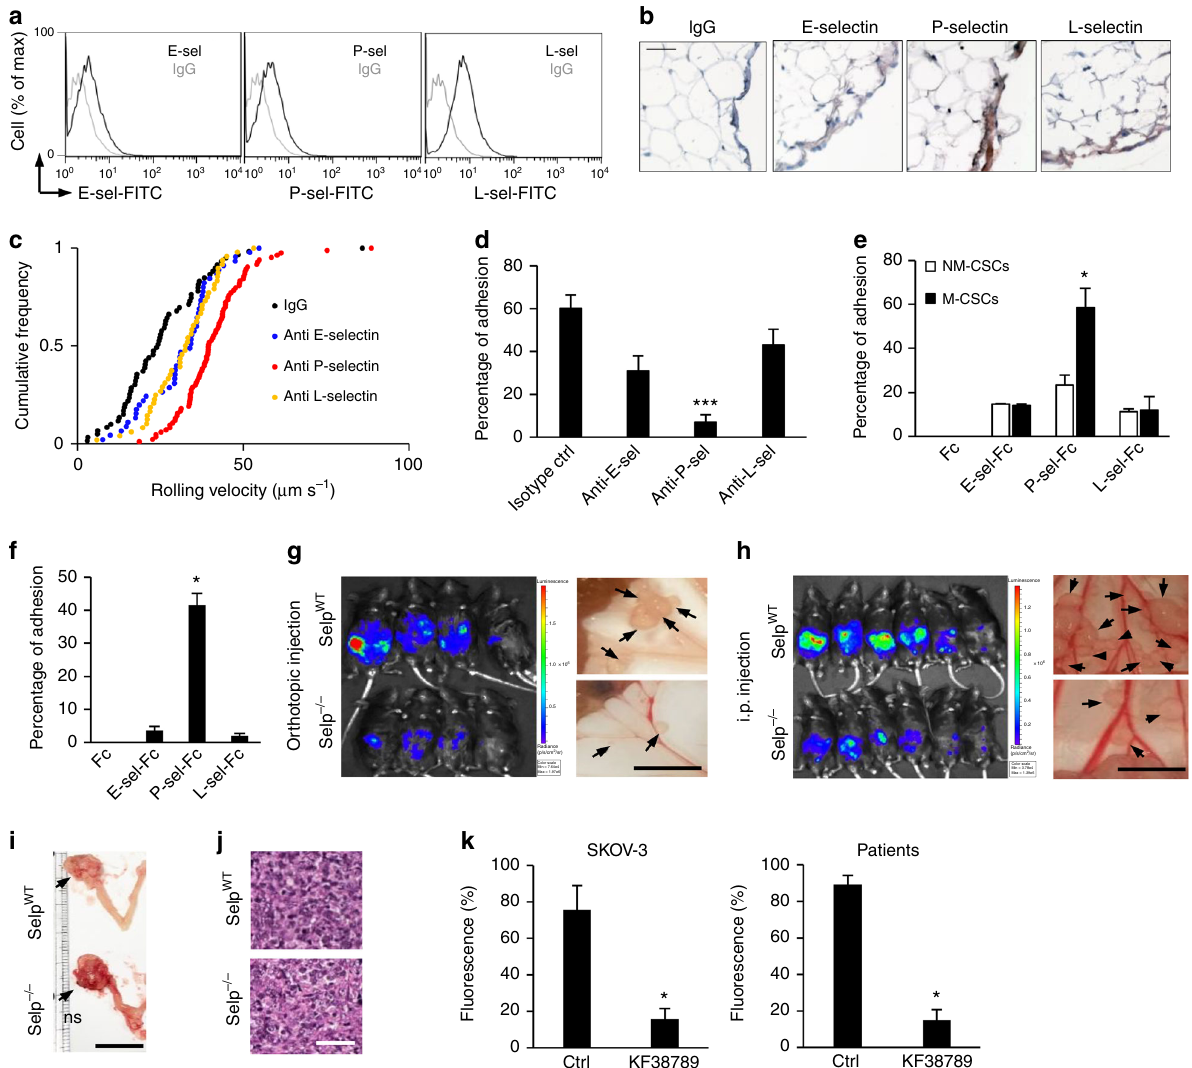
Fig. 3 P-selectin regulates metastatic progression of M-CSCs. a Cell surface expression of selectins on HPMCs. E-selectin (E-sel), P-selectin (P-sel), L- selectin (L-sel). b Human omentum tissues stained with anti-selectin antibodies. Scale bar, 50 μ m. c , d Rolling velocity c , adhesion percentage d of M-CSCs on HPMCs pre-incubated with anti-selectins antibodies or IgG at 0.05 dynes cm − 2 . n = 59, 45, 83, 48. e Percentage of CSCs adhesion onto selectin recombinant proteins or Fc at 0.05 dynes cm − 2 . n = 35/39, 46/45, 52/63, 54/52. f Percentage of patient ascites-derived tumors adhesion onto selectins at 0.05 dynes cm − 2 . n = 100, 131, 160, 247, tumor samples collected from three patients. Data (mean ± SEM) from one of three independent experiments, chi-square test d – f . g , h P-selectin wild-type ( Selp WT ) or knockout ( Selp − / − ) Rag2 de fi ciency mice orthotopically g or i.p. h inoculated with M-CSCs cells. Arrows: metastases. Scale bar, 1 cm. n = 6 mice (orthotopic) or nine mice (i.p.) from two independent experiments. i , j Representative image i and H&E staining i of primary tumors in the ovary. Arrows, tumors. Scale bars = 1 cm i or 50 μ m j . k Fluorescent signal of tumor cells adherent on mouse peritoneum. M-CSCs derived from SKOV-3 (left, n = 3 mice) and patient samples (right, n = 6 mice, tumor samples collected from two patients). Data (mean ± SEM) from two independent experiments, unpaired Student ’ s t test i , k . ns, not signi fi cant. * P < 0.05; ** P < 0.01